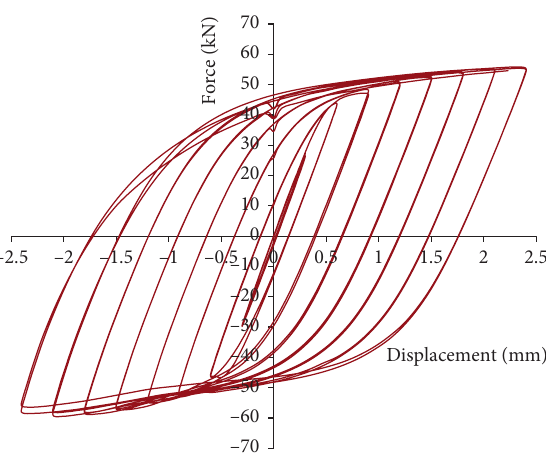
Figure 15: Hysteretic curve of the